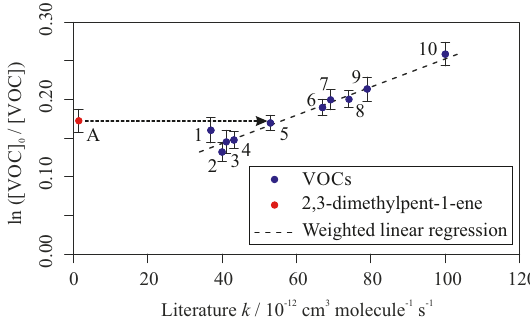
Figure 5. Relative rate plot for Mixture 2 (OH reactivity is 30s − 1 ) at 295K. Compounds with a known rate coefficient are plotted us- ing literature values. Error bars on the y axis, equal to 1 standard error, are calculated by combining the standard error in peak areas for six lamp-off samples and six lamp-on samples. See Fig. S4 for a plot displaying x -axis error bars, which are not shown here due to reasons of clarity. A weighted linear fit was used to generate the slope with a value of OH exp = 1.8 ( ± 0.14) × 10 9 moleculescm − 3 s and R 2 of 0.95. Data for 2,3-dimethylpent-1-ene (A), which has no literature k value, were not used in the calculation of the fit. Identi- ties of VOCs: 1, 1-hexene; 2, 1-heptene; 3, 1-octene; 4, 1-nonene; 5, α -pinene; 6, cyclopentene; 7, cyclohexene; 8, cycloheptene; 9, β -pinene; 10,